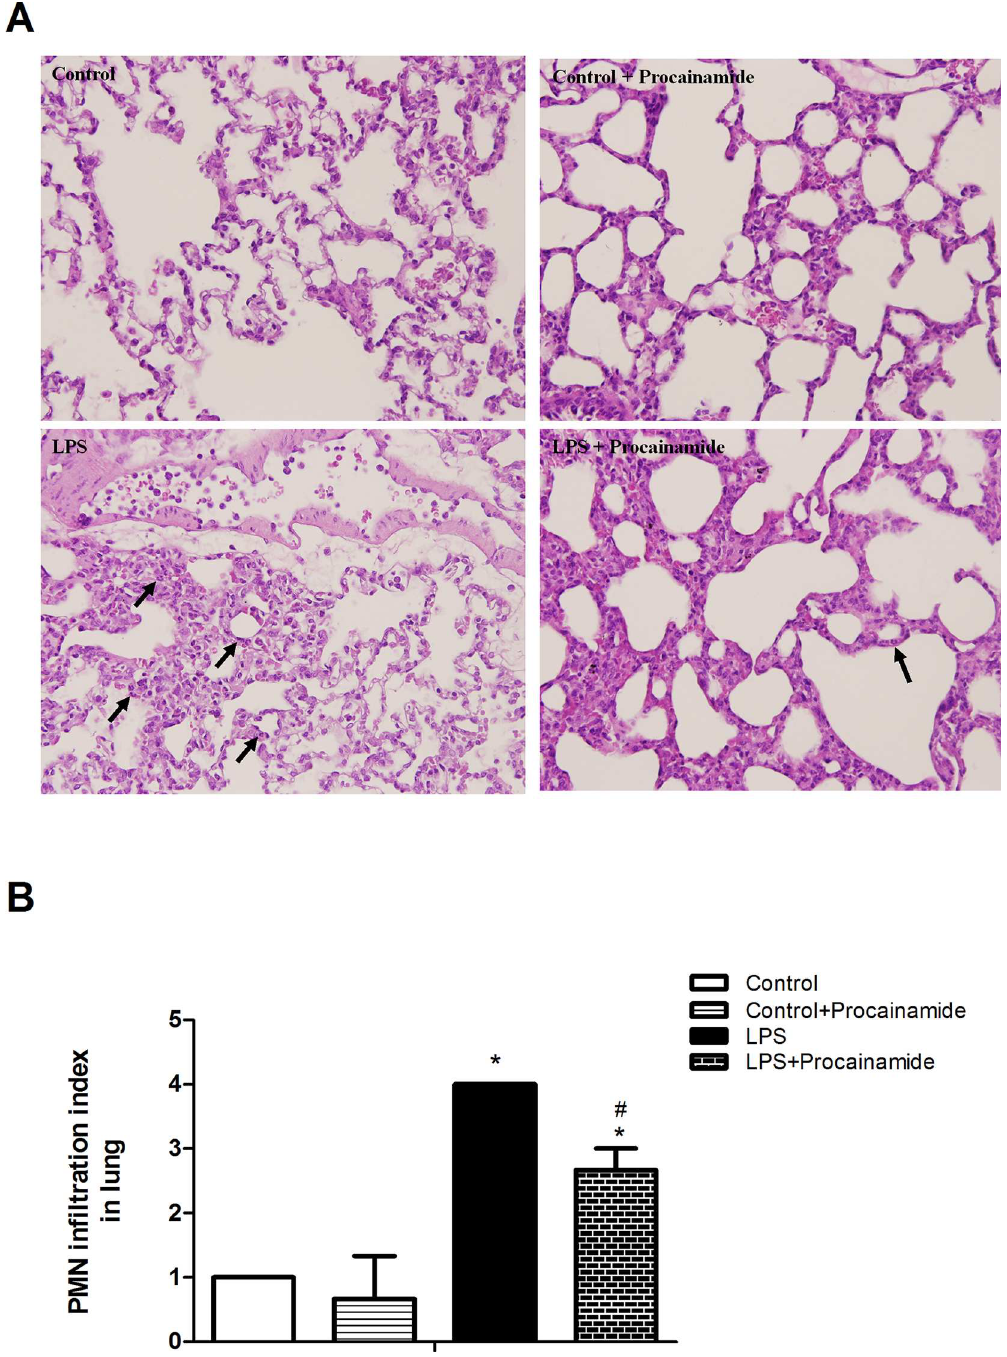
Fig 5. (A) Representative histopathologic features and (B) polymorphonuclear neutrophil (PMN) infiltration index of lung tissue sections obtained from endotoxemic rats. Depicted are changes in PMN infiltration index at the end of experiment (at 6 h) in different groups of animals that received saline at time 0 (Control, n = 3), received saline as in Control group and then received procainamide at 1 h (Control + Procainamide, n = 3), received LPS at time 0 (LPS, n = 3), and received LPS at time 0 and then received procainamide at 1 h (LPS + Procainamide, n = 3). Data are expressed as mean ± SEM. * P < 0.05, all versus Control rats; # P < 0.05, with versus without procainamide in LPS rats. Arrows represent neutrophil infiltration. Original magnification x 200.